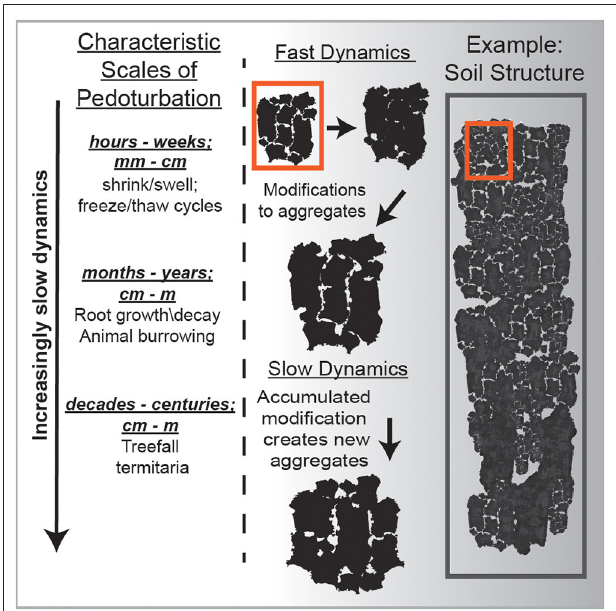
FIGURE 2 | A conceptual illustration using soil aggregates to differentiate between the fast degrees of freedom vs. the slow degrees of freedom. Importantly, making a single measurement of the microscopic soil temperature using a dial thermometer would not reflect the dynamics which give rise to the slower processes. Rather you would have to measure the temperature over days, weeks, years to begin to capture those long-term dynamics such as shrink/swell or